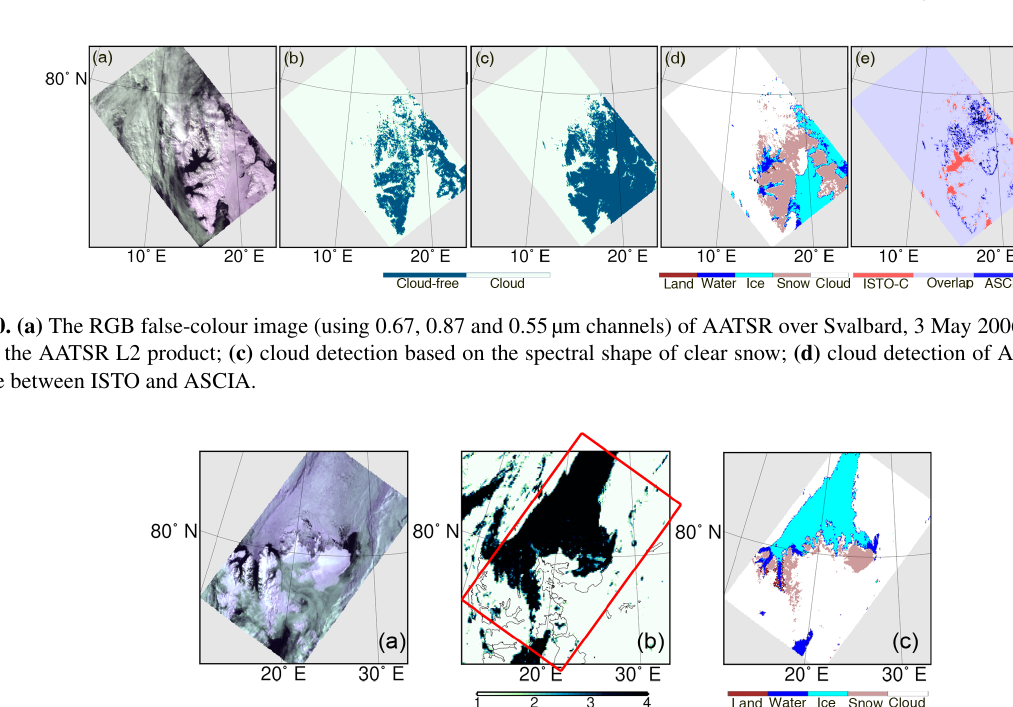
Figure 11. (a) RGB false-colour image (using 0.67, 0.87 and 0.55µm channels) of AATSR over Svalbard, 14 July 2008, 16h 40min 45s, (b) MODIS cloud mask algorithm retrieved data: 1 is cloudy, 2 is probably cloudy, 3 is probably clear, 4 is clear (red rectangle shows the coverage of AATSR) for 16h 25min, (c) the results for the cloud detection of ASCIA.